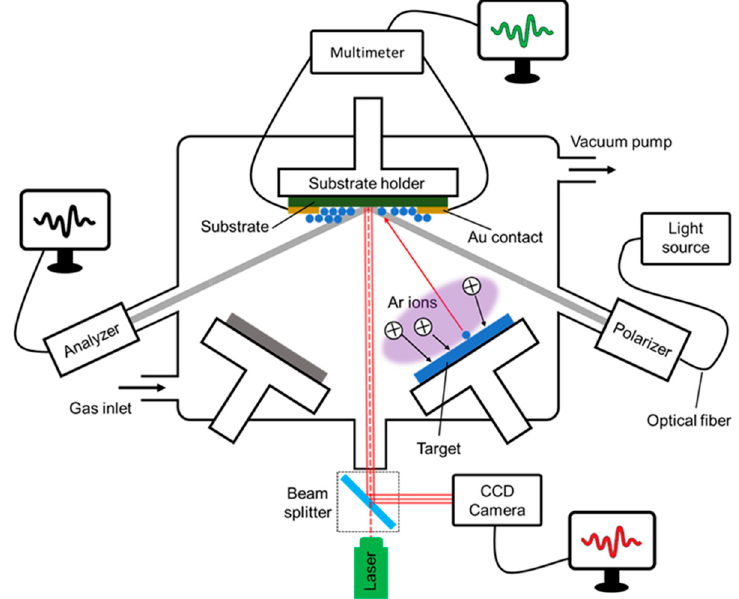
Figure 1. Generic schematic illustration of the sputter-deposition chamber used for collecting data reported in this work. The chamber is equipped with several in situ diagnostics which allow real-time growth monitoring: the wafer curvature set-up is attached at the bottom flange of the chamber and consists of a multiple-beam laser illuminating the substrate at near-normal incidence; the set-up for spectroscopic ellipsometry, operating at an incidence angle of ~70 ◦ , consists of a light source, polarizer, and analyzer. The sample holder stage can be fitted with a custom-built four-point probe apparatus to measure the change in electrical resistance during